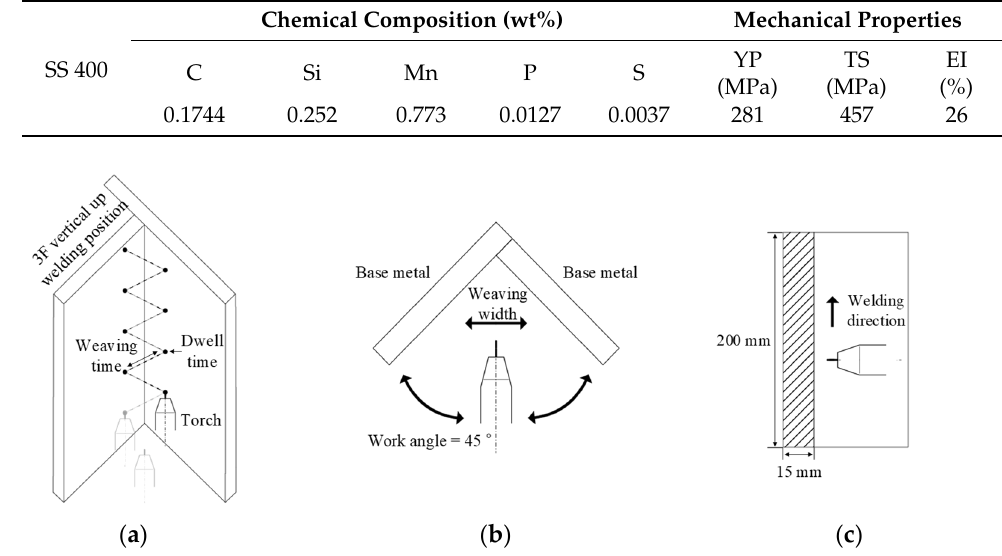
Table 1. Chemical composition and mechanical properties of the base metal.